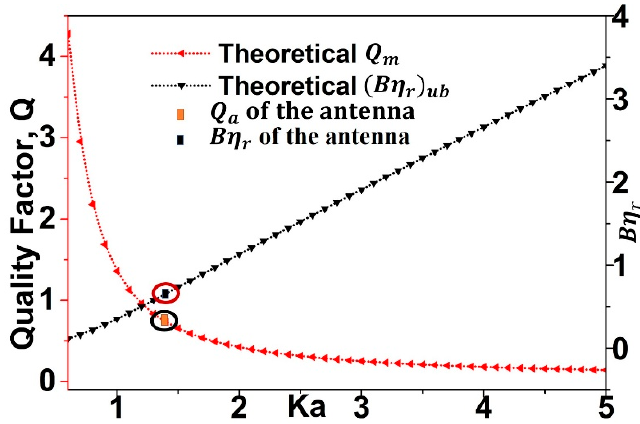
Figure 11. Theoretical limits and calculated Q a and (B η r) ub .